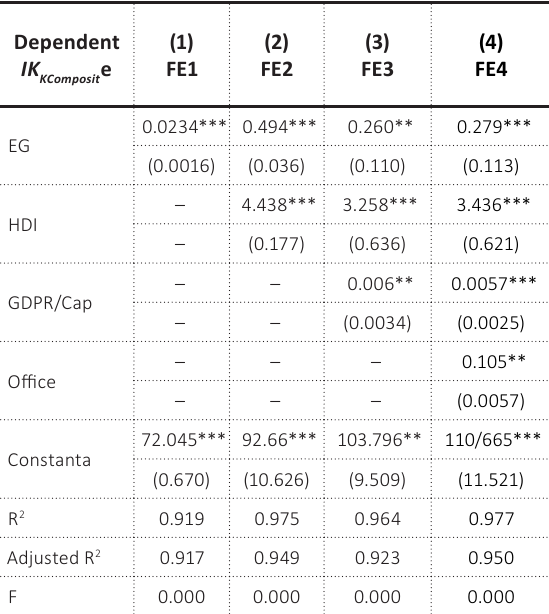
Table 5. Effect of EG, HDI, GDPR/Cap and Office on IKK